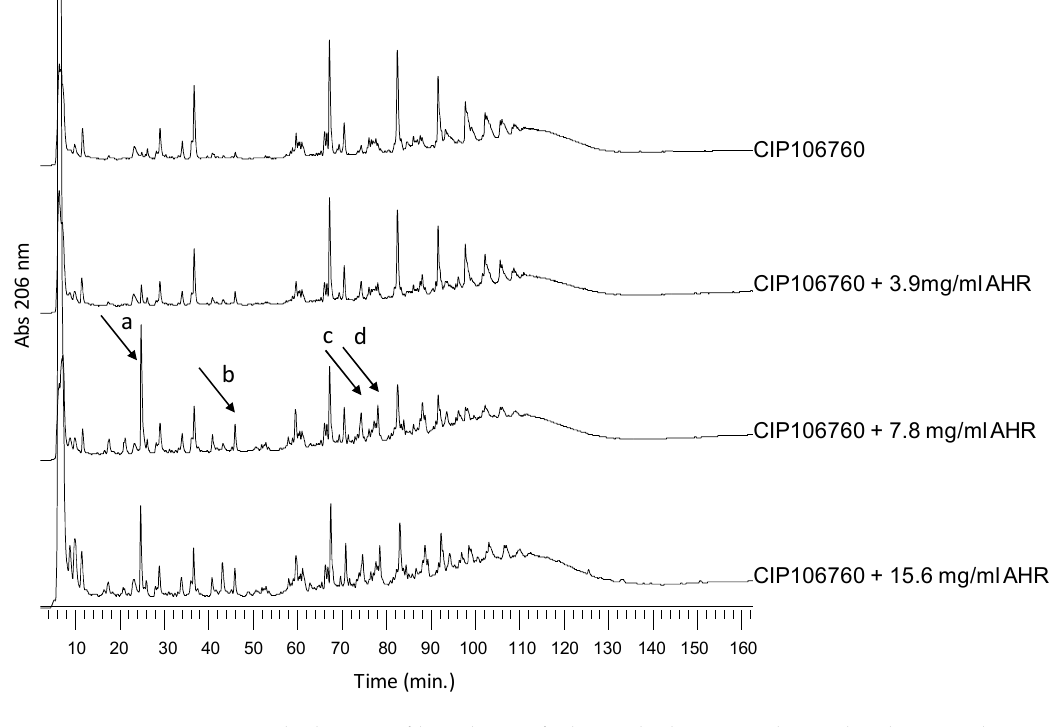
Figure 6. RP-HPLC peptidoglycan profiles. The purified peptidoglycan was digested with mutanolysin, reduced and analyzed by RP-HPLC. Muropeptide profiles of CIP106760 strain challenged with MIC/2, MIC and 2MIC concentrations of AHR. Muropeptide structures corresponding to peaks a, b, c and d (highlighted by arrows) are over-represented in the peptidoglycan of CIP106760 challenged with MIC and double MIC concentrations of AHR.